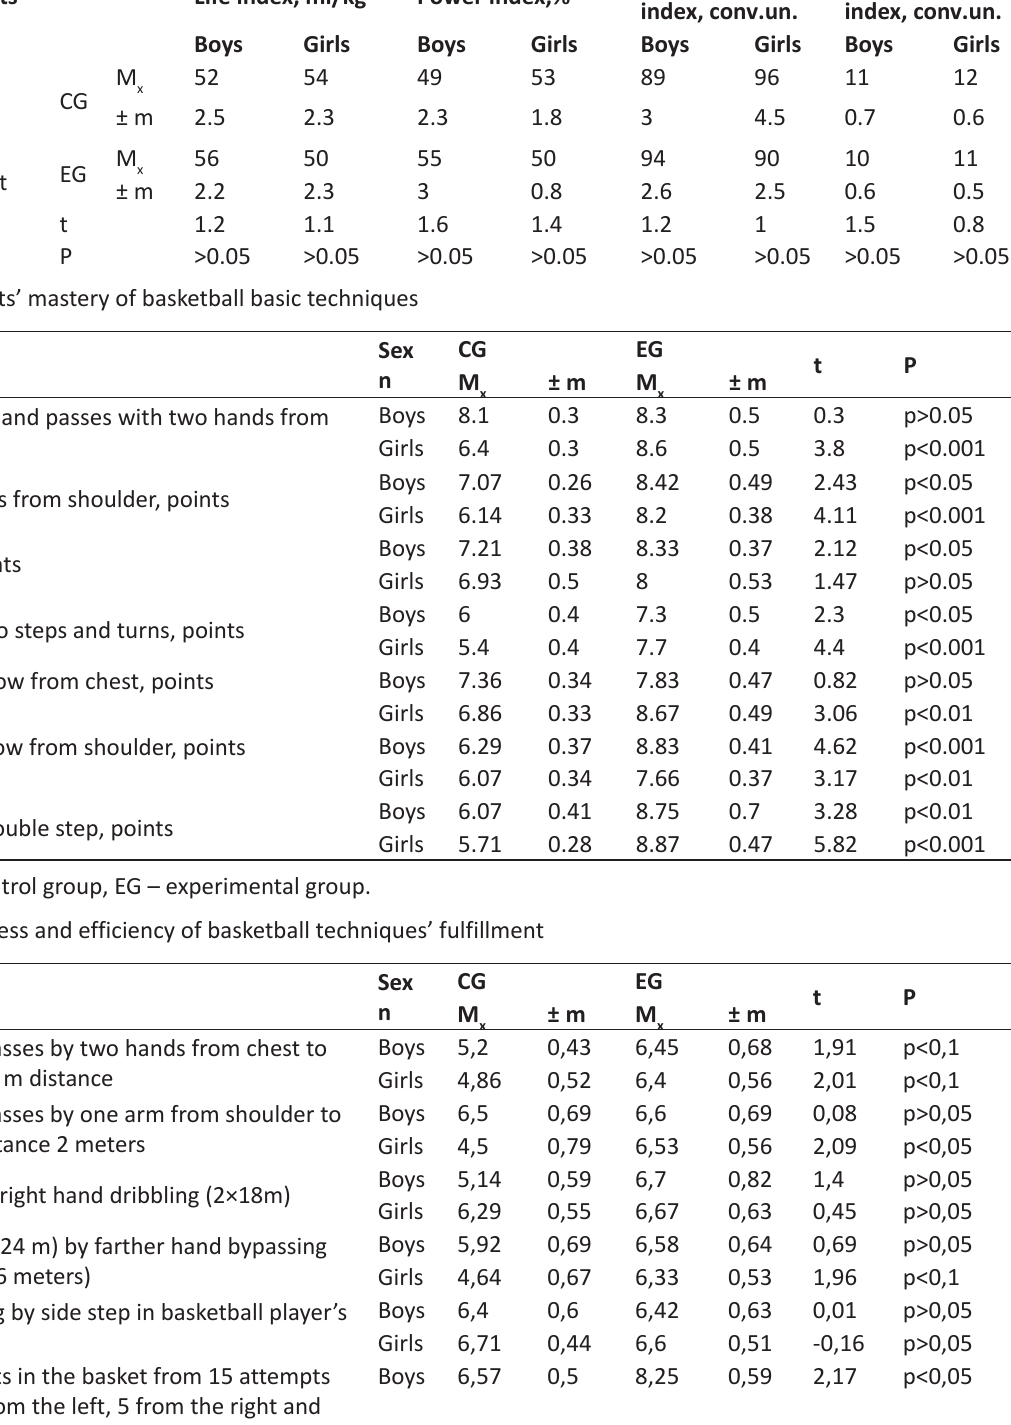
Table 1. Indicators of students’ physical health before and after experiment Functional tests